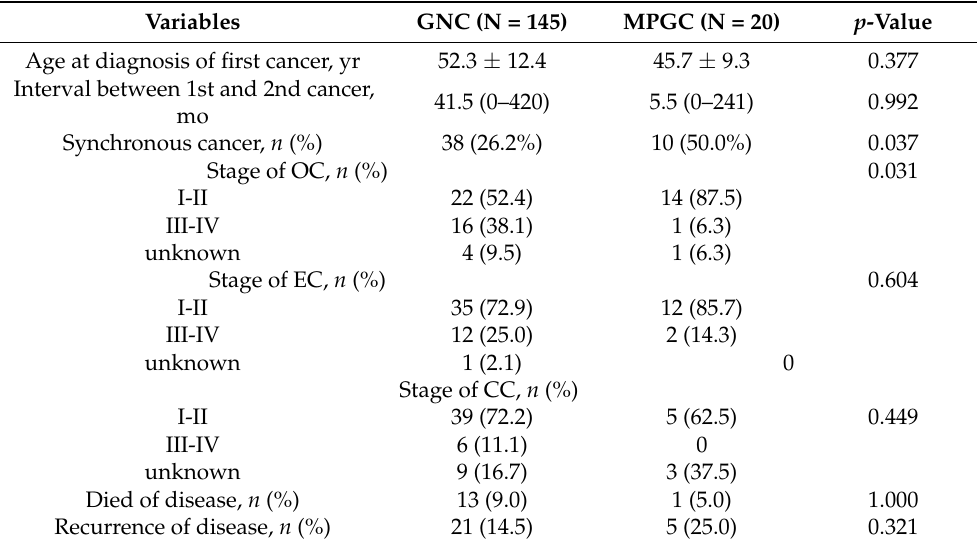
Table 1. Comparison of patient characteristics between non-gynecologic cancer (GNC) and multiple primary gynecologic cancers (MPGC).